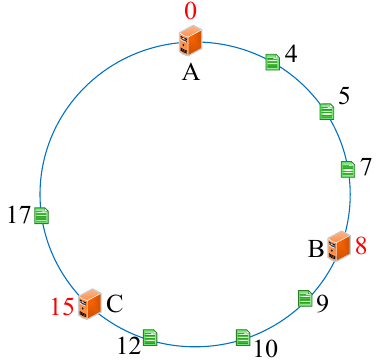
Figure 7. The final mapping of servers and applications to the hash circle.